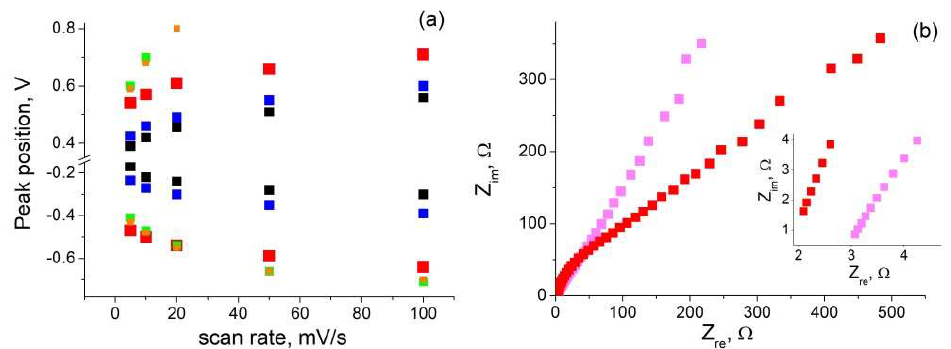
Figure 3. Dependence of the redox peak position on scan rate for por-Si samples of different depths: 13 μm (black), 19 μm (blue), 80 μm (red), 150 μm(green), 180 μm (orange). Numerical data are given in SM, Table S5a,b ( a ). Nyquist plots (inset: high frequency detail plots) for 80 μm sample before (pink) and after (red) GLC deposition ( b ).